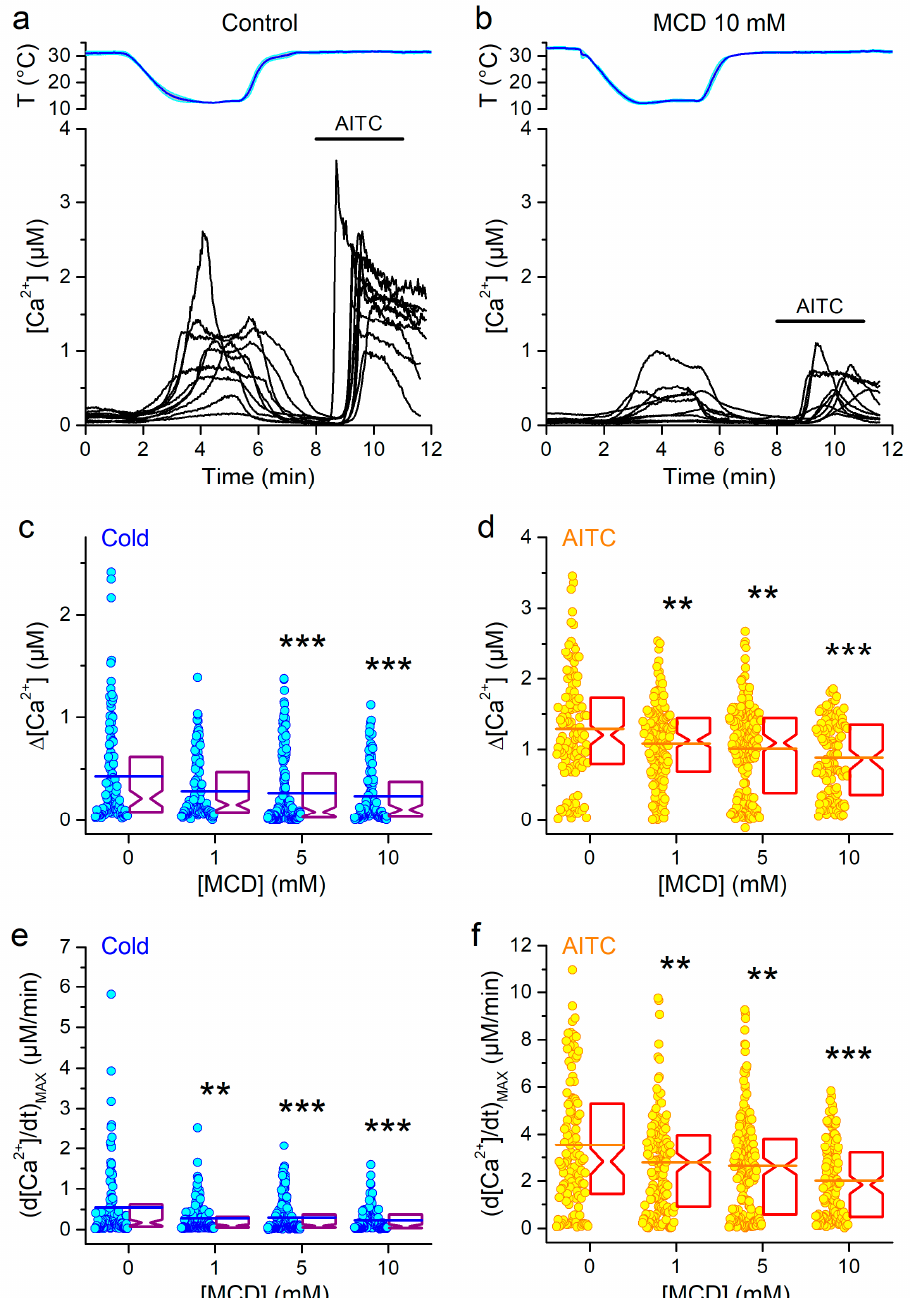
Figure1. E ff ectsofcholesteroldepletiononcold-inducedresponsesofmTRPA1. ( a and b )Representative traces of [Ca 2 + ] change induced by cooling (upper panels) in the control condition ( a ) and after pretreatment with 10 mM MCD ( b ). Application of AITC (100 µ M) was used as control for mTRPA1 activation. ( c and d ) Amplitudes of [Ca 2 + ] responses evoked by cold ( c ) and AITC ( d ) in control condition ( n = 118) or after pretreatment with 1 ( n = 149), 5 ( n = 202) or 10 mM ( n = 130) of MCD. ( e and f ) Maximal amplitudes of the first time derivative of the intracellular Ca 2 + signal elicited by cold ( e ) and AITC ( f ) in control condition or after treatment with 1, 5 or 10 mM of MCD (the n numbers are the same as in panels c and d). The symbols *, ** and *** indicate p < 0.05, p < 0.01 and p < 0.001, respectively; Kolmogorov–Smirnov